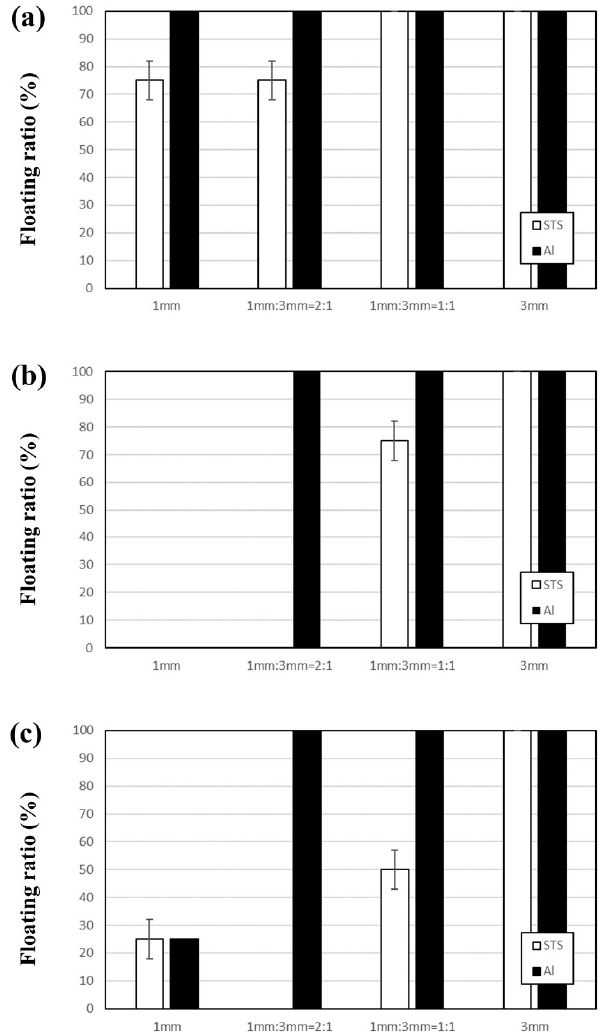
Figure 9. Floating ratios of Al and STS scraps at 4 min by vibrating with vibration amplitudes of ( a ) 2, ( b ) 2.5, and ( c ) 3 mm using a ball bed with various ratios of 1-mm and 3-mm balls.